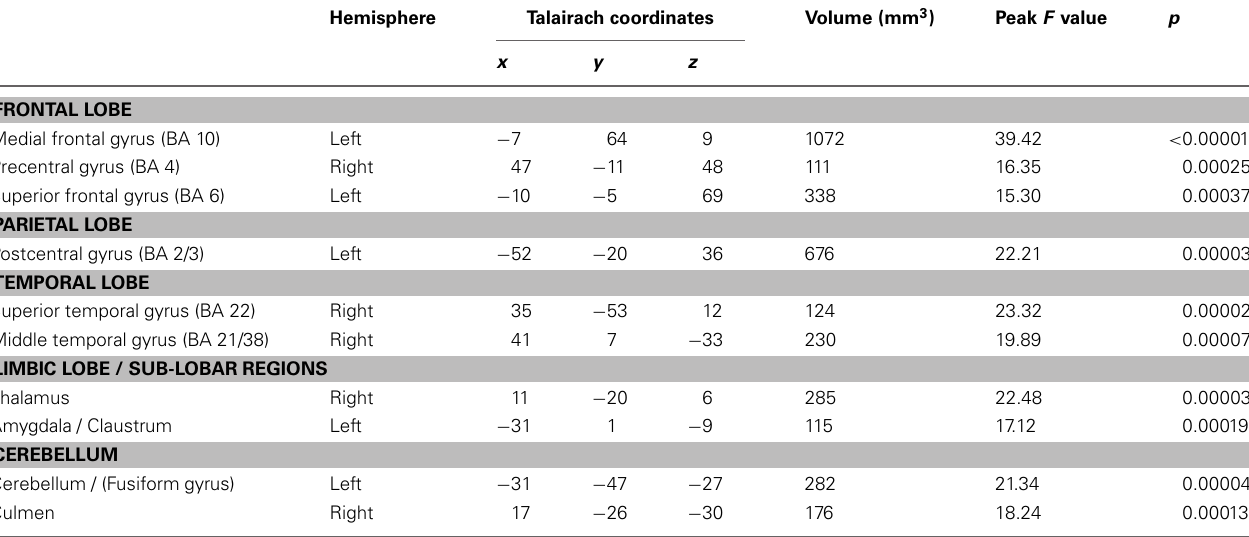
Table 3 | Areas of infant identity x affect interaction in whole brain